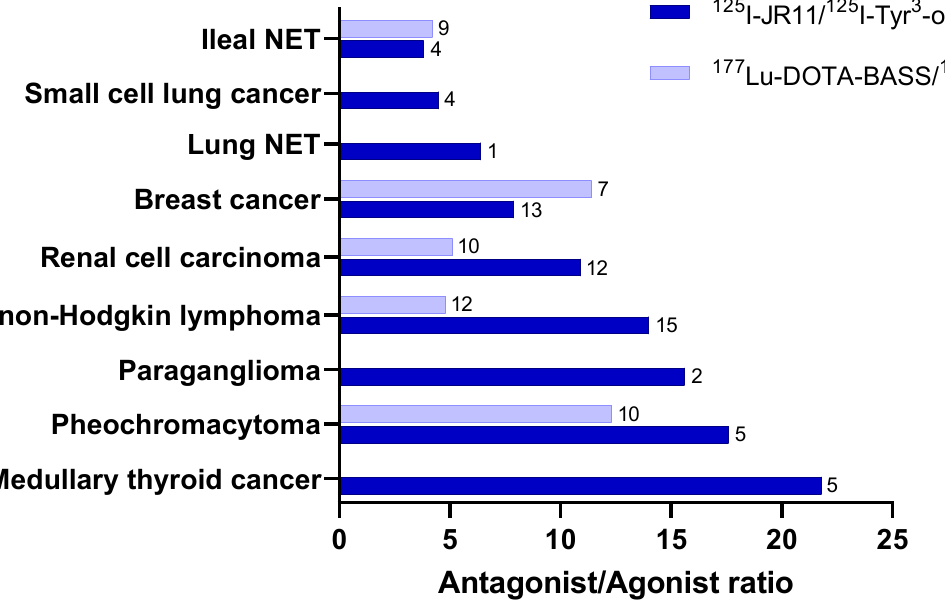
Figure 3. Radiolabeled SST 2 agonist/antagonist binding in different human tumors. 125 I-JR11/ 125 I- Tyr 3 -octreotide data are from [63]. 177 Lu-DOTA-BASS/ 177 Lu-DOTA-TATE data are from [39]. Num- bers indicate the samples sizes.